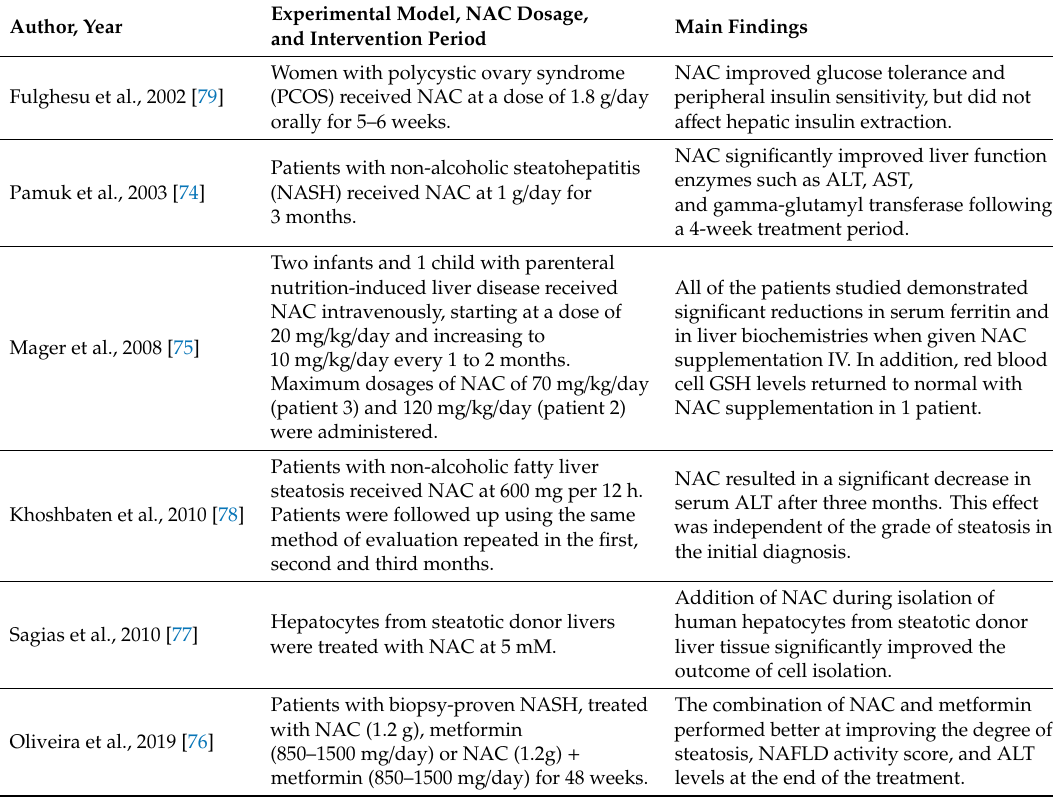
Table 4. Clinical studies reporting on the impact of N-acetyl cysteine (NAC) on liver function in conditions of metabolic syndrome and